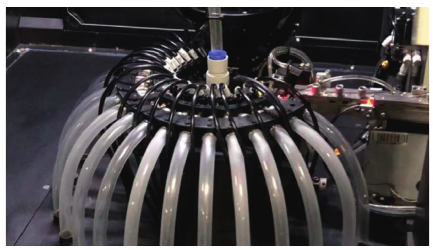
Figure 6: Mechanism inside a bin-sorting